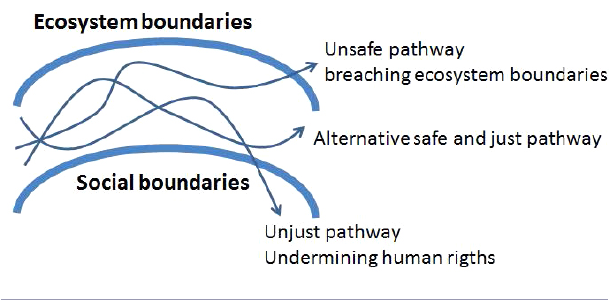
Fig. 4 . Possibilities within the safe and just space: diverse pathways, alternative directions, and varying distributional outcomes (adapted from a plenary